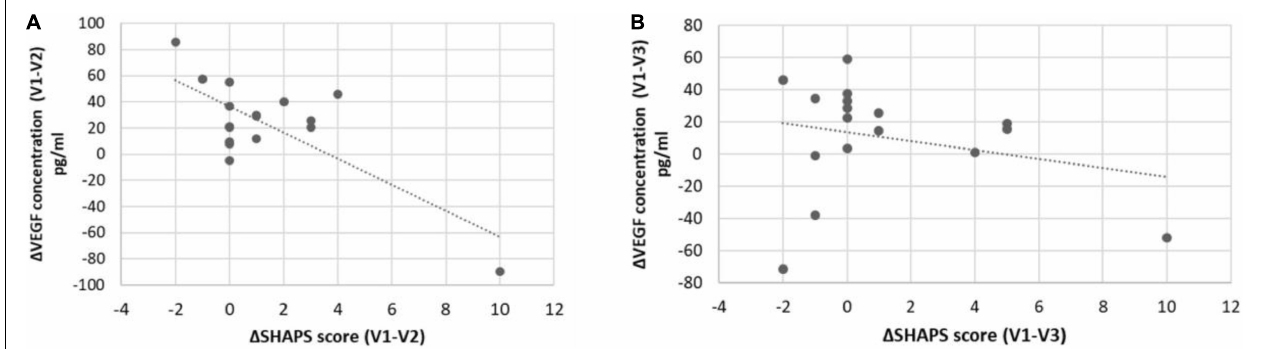
FIGURE 1 | Associations between (cid:49) SHAPS scores and serum (cid:49) VEGF concentrations in responders and non-responders. SHAPS score reduction was significantly ( p = 0.001; R = − 0.72) associated with a change in serum VEGF concentration in responders (A) but is not significantly ( p > 0.05; R = − 0.25) associated in non-responders (B)